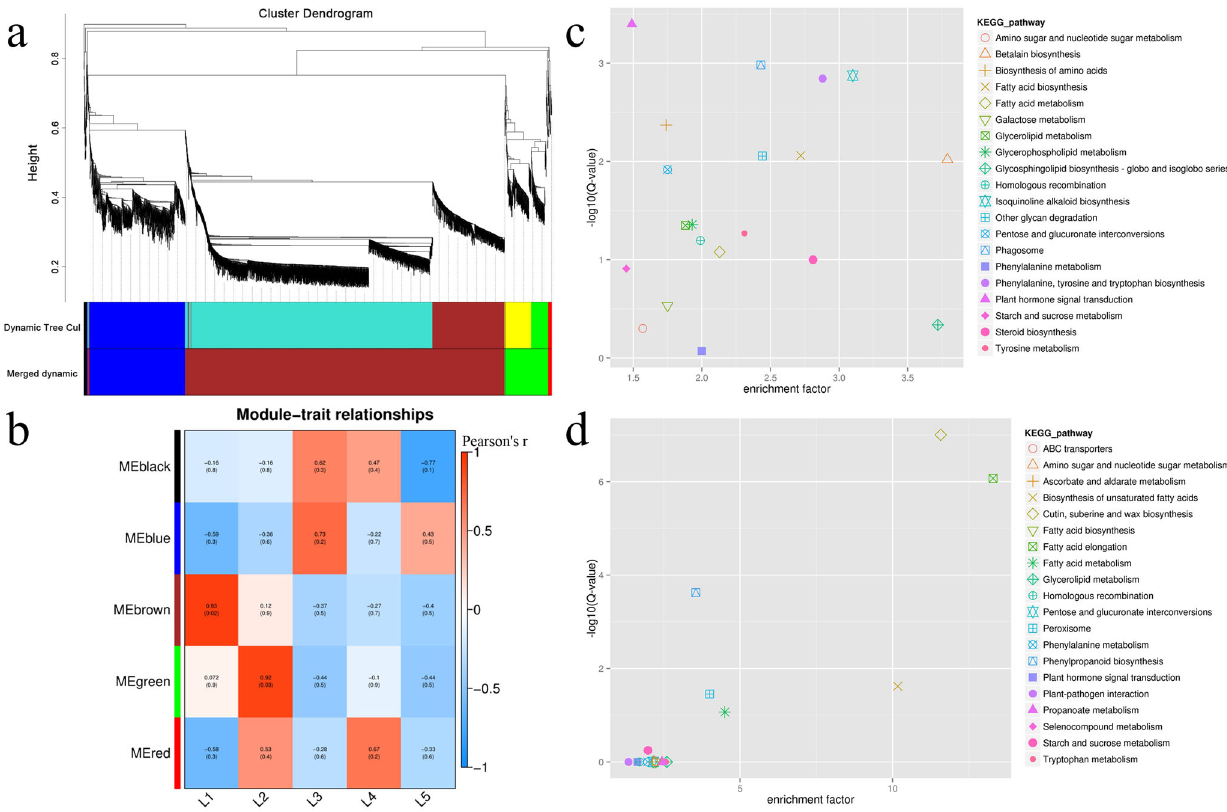
Fig. 4 Weighted gene co-expression network analysis (WGCNA) of genes during the leaf development. a Hierarchical cluster tree showing co- expression modules identi fi ed by WGCNA. b Module-stage association (each row corresponds to a module, and each column represents a speci fi c stage. The color of each cell at the row column intersection indicates the Pearson correlation coef fi cient (Pearson ’ s r) between a module and the stage), positive and negative correlations are shown in red and blue, respectively. c KEGG enrichment analysis of genes in brown module. d KEGG enrichment analysis of genes in green module. Each sample for WGCNA had three biological